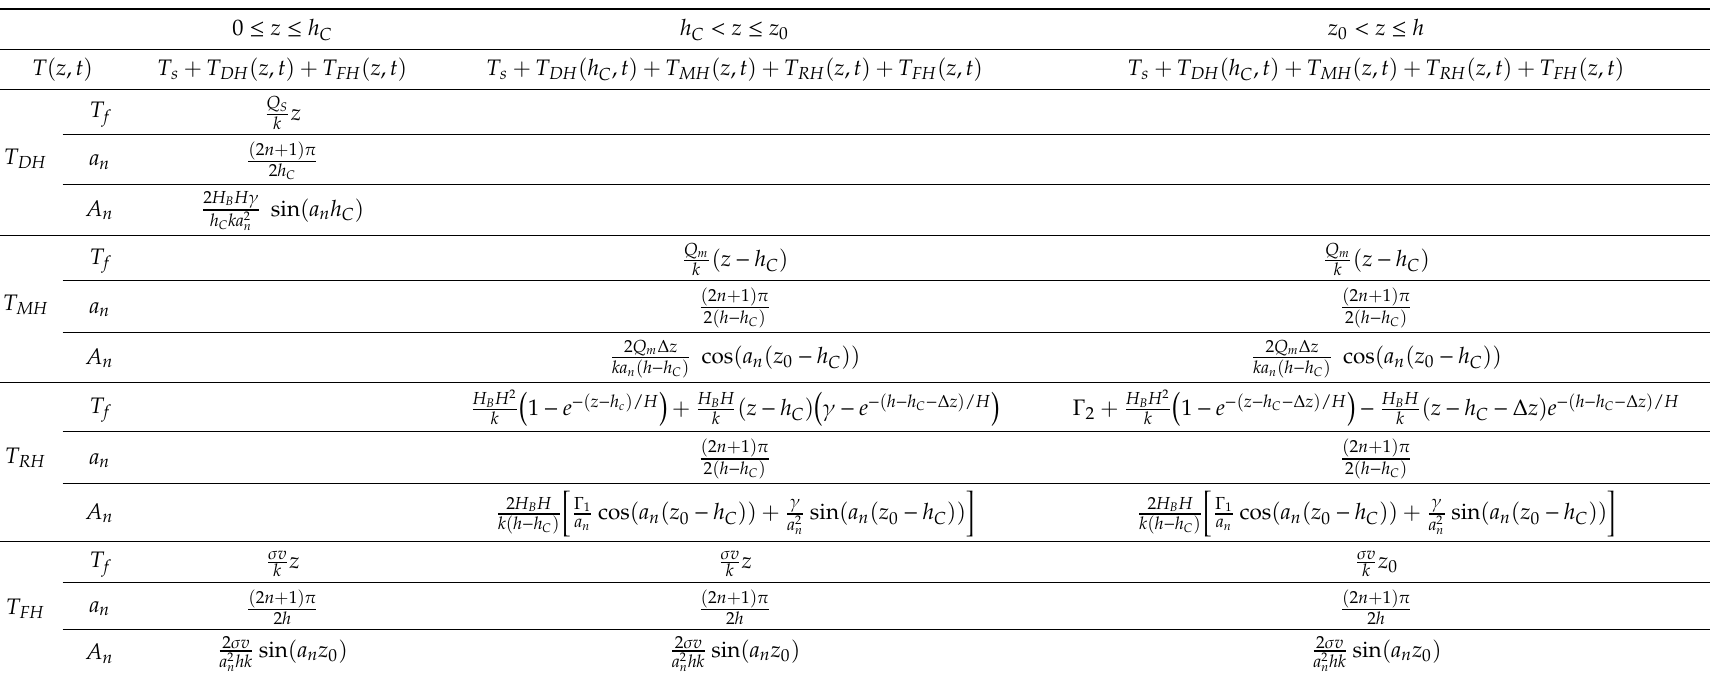
Table 1. List of terms included in the equations adopted in the analytical